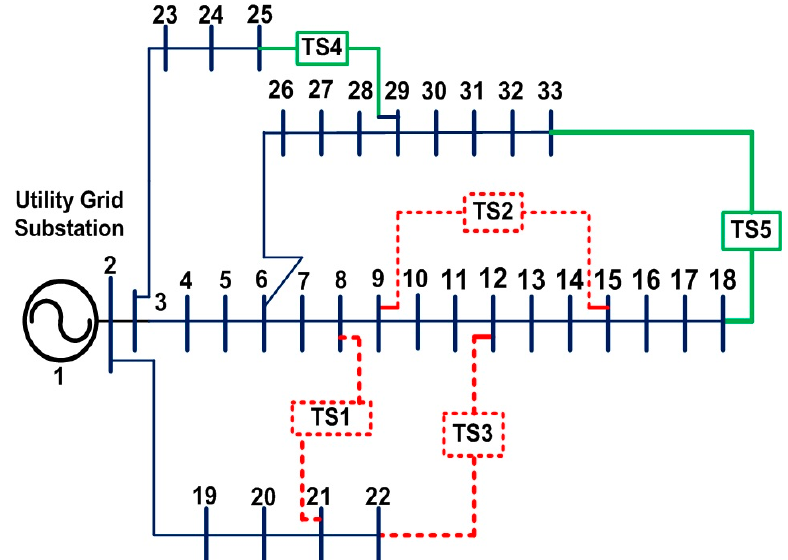
Figure 4. 33-bus (meshed configured) test distribution system.